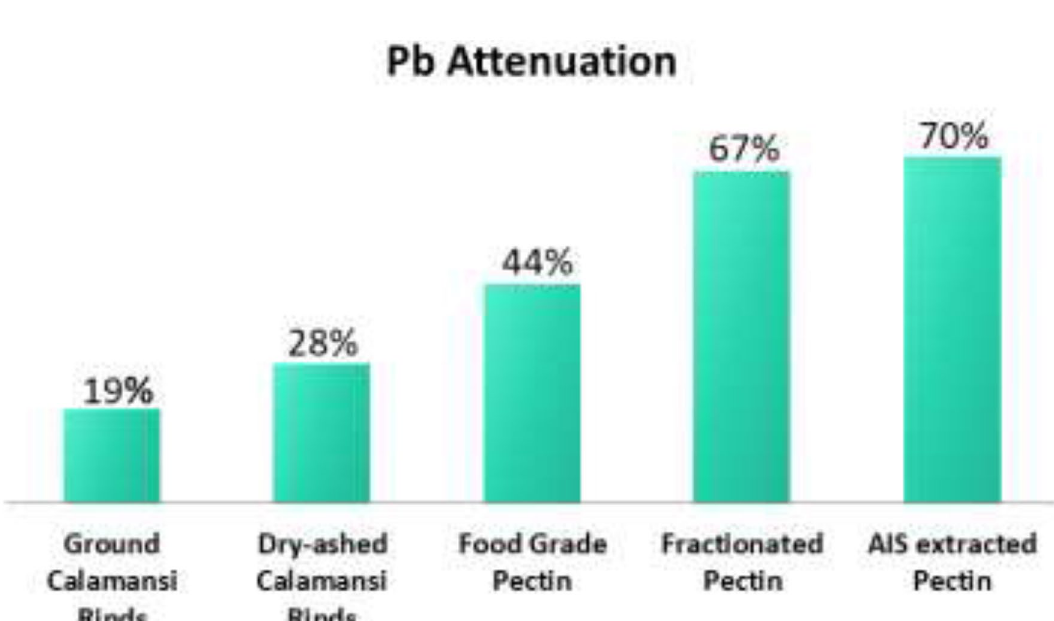
Figure 18. Lead attenuation of different forms of calamansi rinds